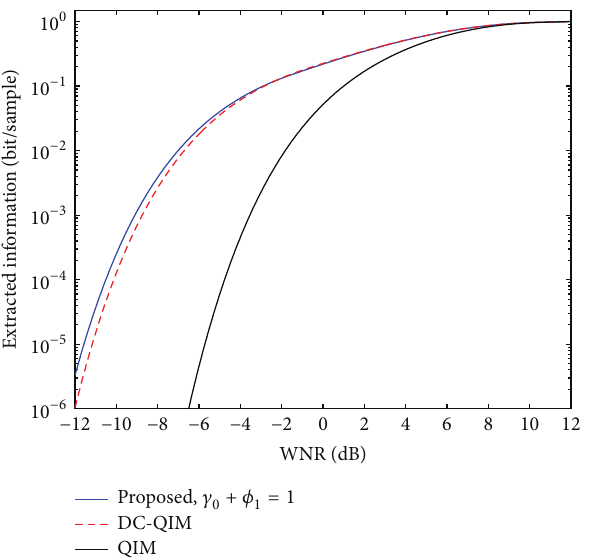
Figure6:Analytic-basedestimationofinformationextractedunder AWGN without IDL.